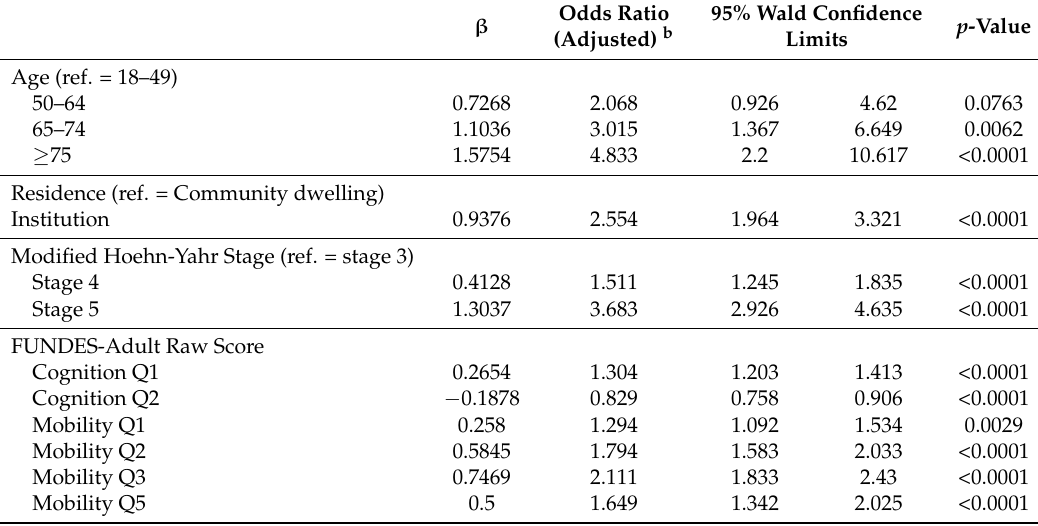
Table 4. Logistic regression, event = not ambulatory, n = 6144 a